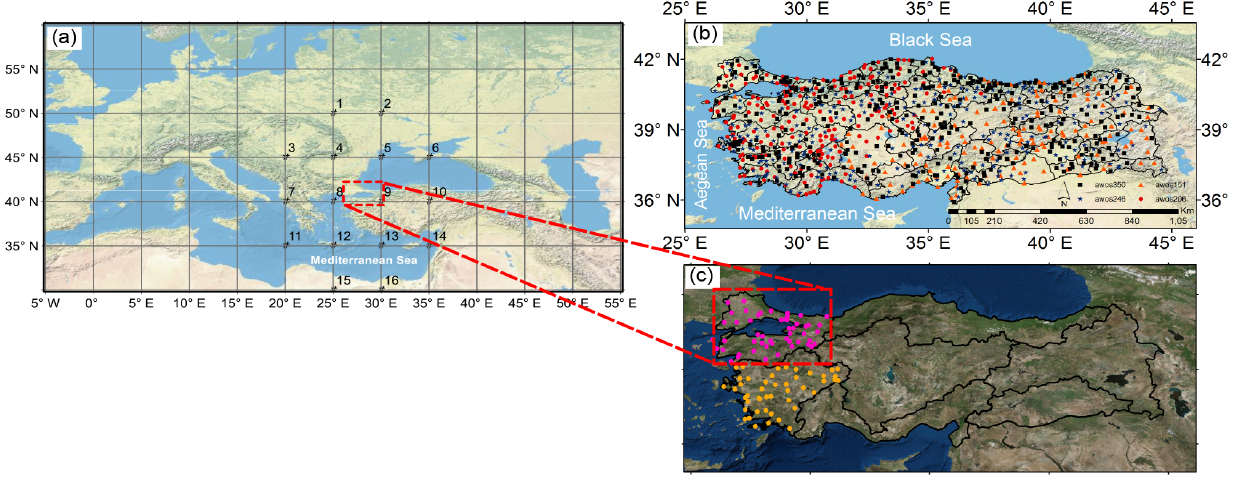
Figure 1. (a) The 16 mean sea level pressure (MSLP) grid points used in the Lamb weather type analysis. The dashed rectangle covers the Marmara Region. (b) The distribution of a total of 953 automatic weather observing systems (AWOSs) over Turkey depending on the four projects (AWOS 206, 151, 246, and 350), and (c) the locations of the 51 (pink points) and 46 (light brown points) AWOS stations, at the Marmara and Aegean regions, respectively. Hourly precipitation data of these 97 stations were provided by the Turkish State Meteorological Service (TSMS) for the period of